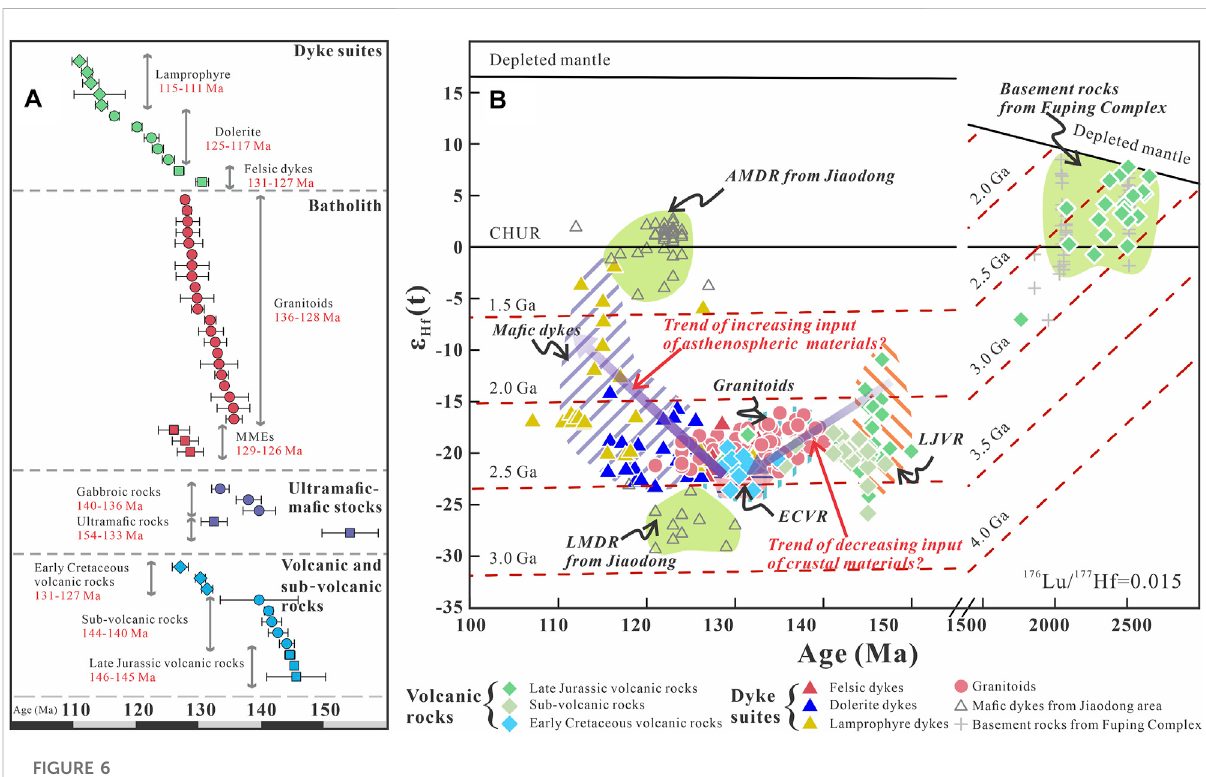
FIGURE 6 (A) Compilation of age data on the Laiyuan magmatic rocks. See Table 1 for data source. (B) Zircon ε Hf (t) values vs age diagram for the Laiyuan magmaticrocks.Datasource:BasemenrocksoftheFupingComplex(Tangetal.,2015;Tangetal.,2016);GranitoidsfromtheLaiyuancomplex(Shen et al., 2015a; Yang et al., 2019b; Xue et al., 2021); Late Jurassic volcanic rocks (Duan et al., 2016); Sub-volcanic rocks (Qu, 2012; Shen et al., 2015b); Early Cretaceous volcanic rocks (Xue et al., 2021); Dyke suites from the Laiyuan complex (Xue et al., 2019b) and Shandong Peninsula (Ma et al., 2014; Ma et al.,